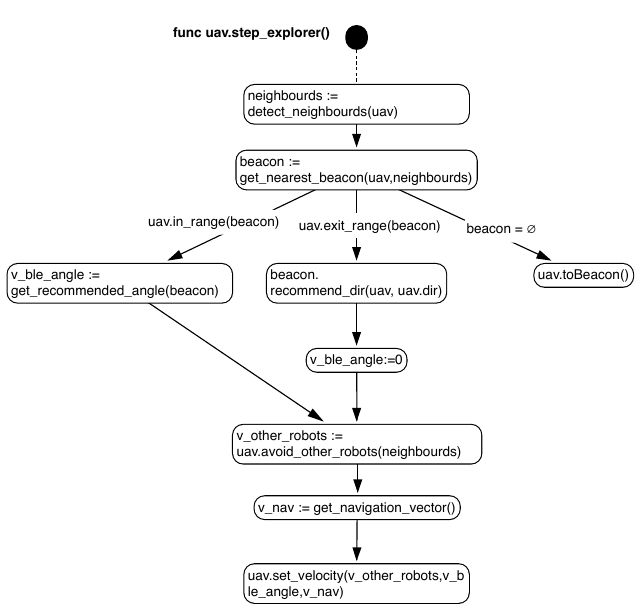
Figure 4. State diagram for the slant beacon deployment (SLABE) behavior of individuals of type active . For each processing step, any individual in this role will execute the steps listed in the diagram.